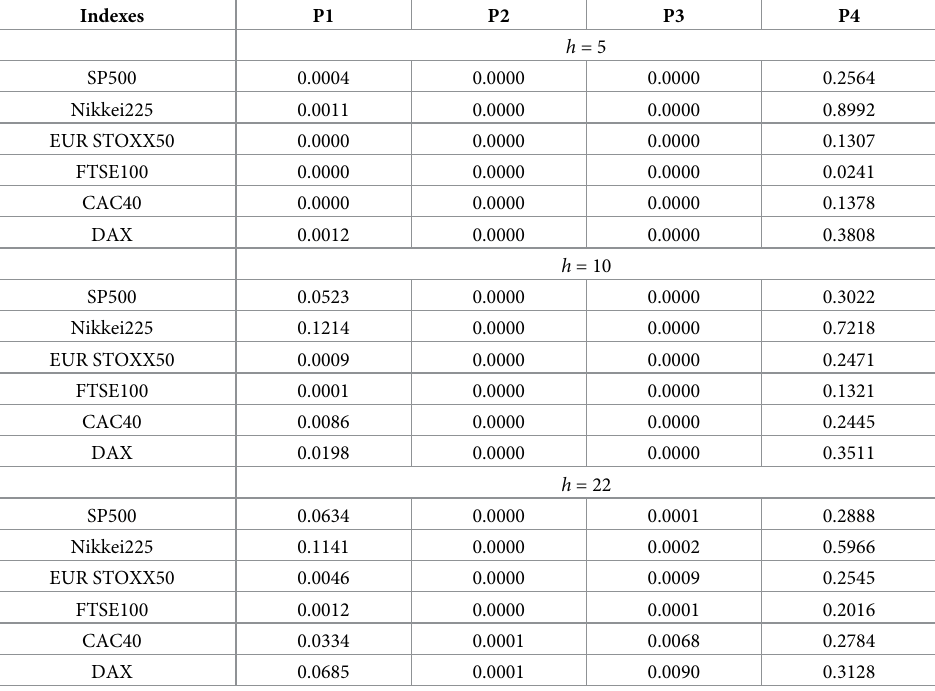
Table 7. Out-of-sample forecasts performance comparation of LHAR, LHARO, LHARV and LHAROV (long forecasting